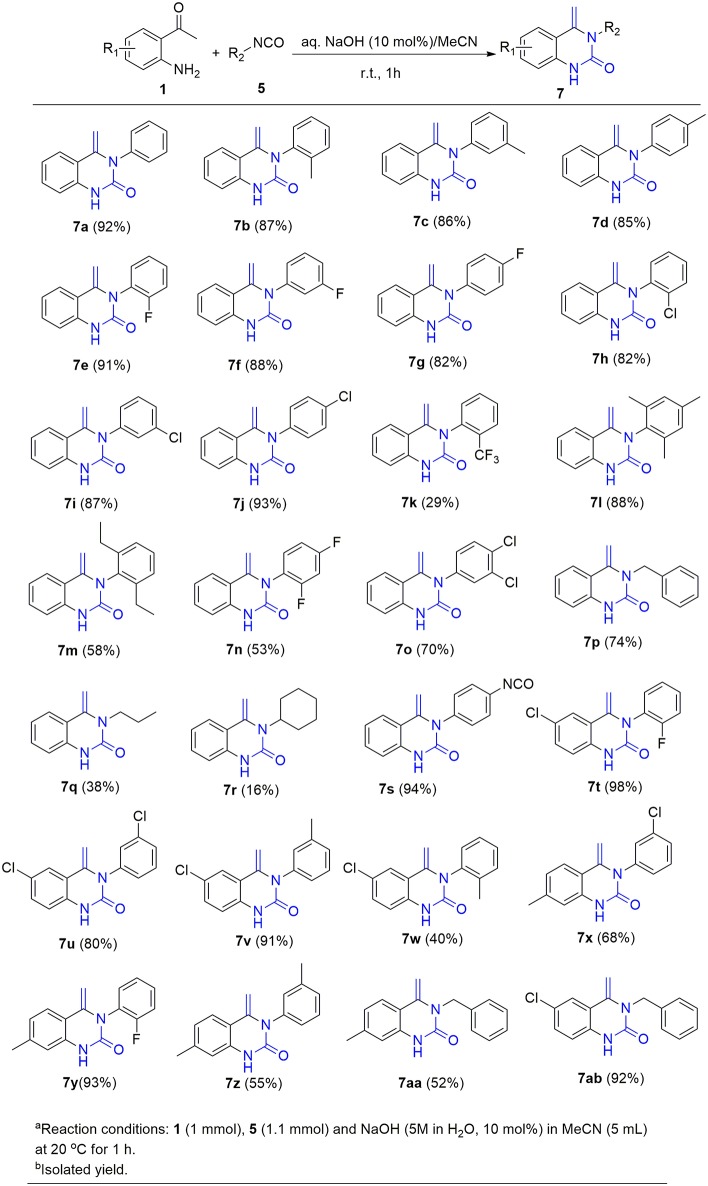
Substrate scope of isocyanatesa,b.